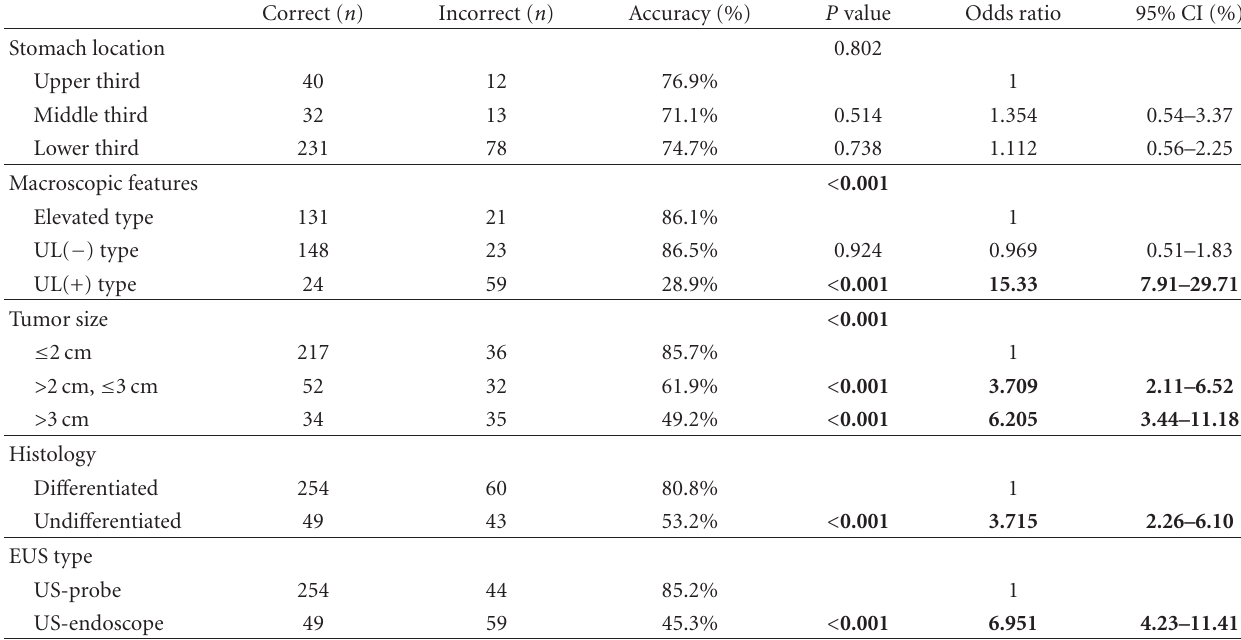
Table 3: Univariate analysis of factors a ff ecting accuracy of determinations of the depth of cancer invasion.